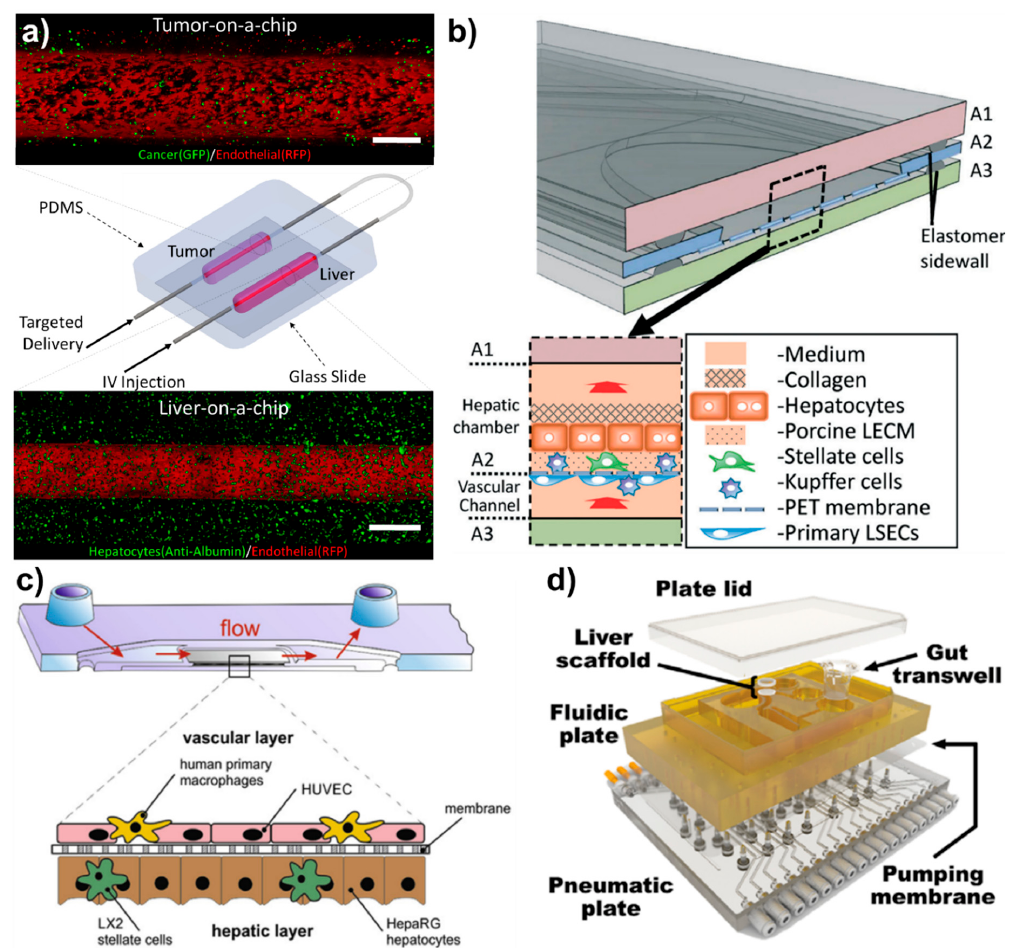
Figure 2. Novel vascularized liver-on-a-chips. a) Vascularized liver-on-a-chip incorporated with tumor-on-a-chip to investigate enhanced permeability retention (EPR) effect of different nanoparticles under physiological wall shear stress. Flow direction could be controlled to simulate targeted delivery (tumor to liver) and IV injection (liver to tumor). Scales are 500 μ m. Reproduced from [8] with permission from Wiley. b) The vascularized liver acinus microphysiology system (vLAMPS). The vLAMPS is constructed from 3 glass layers. The intermediate layer contains an elliptical opening with a Polyethylene terephthalate (PET) membrane with pores that spans the opening and is attached to the bottom. Reproduced from [67] with permission from the Royal Society of Chemistry. c) The three-dimensional liver organoid consists of a vascular layer formed by endothelial cells and primary macrophages, and a hepatic layer comprising hepatocyte-like HepaRG cells co-cultured with stellate cells. The space of Dissé (SD) is mimicked by the biochip-embedded membrane serving as a scaffold allowing cell-cell communication through its pores. Reproduced from [100] with permission from Elsevier. d) Exploded view of a multi-MPS platform. The top plate (shown in yellow polysulfone) contains MPS compartments and distributes culture medium through micromachined channels and pumps on its bottom face. The bottom plate (shown in clear acrylic) distributes compressed air and vacuum to small ports below each pump/valve chamber. Reproduced from [94] with permission from Wiley.